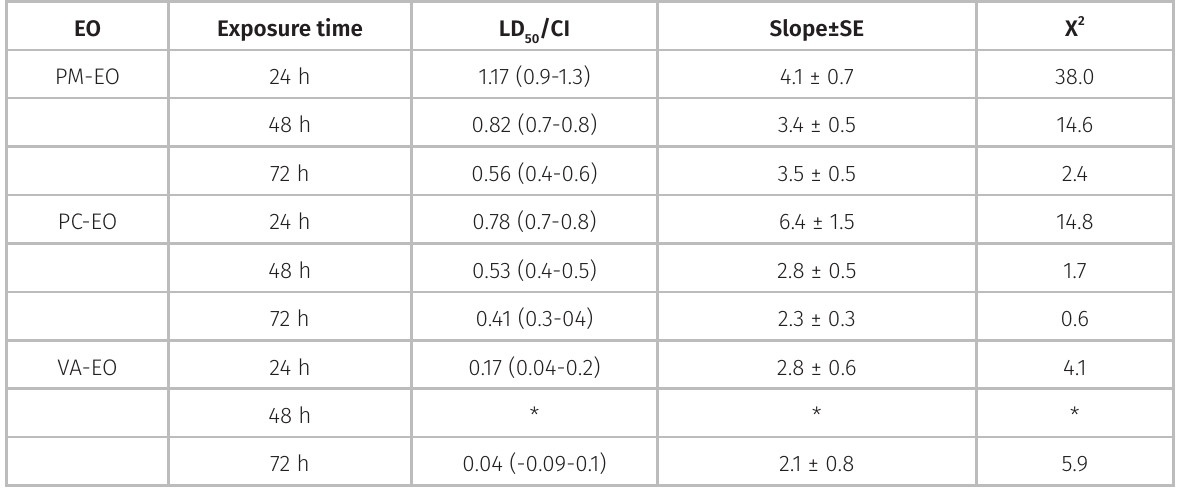
Table III. Essential oil LD as determined by the fumigant activity assay. against Z. subfasciatus 50